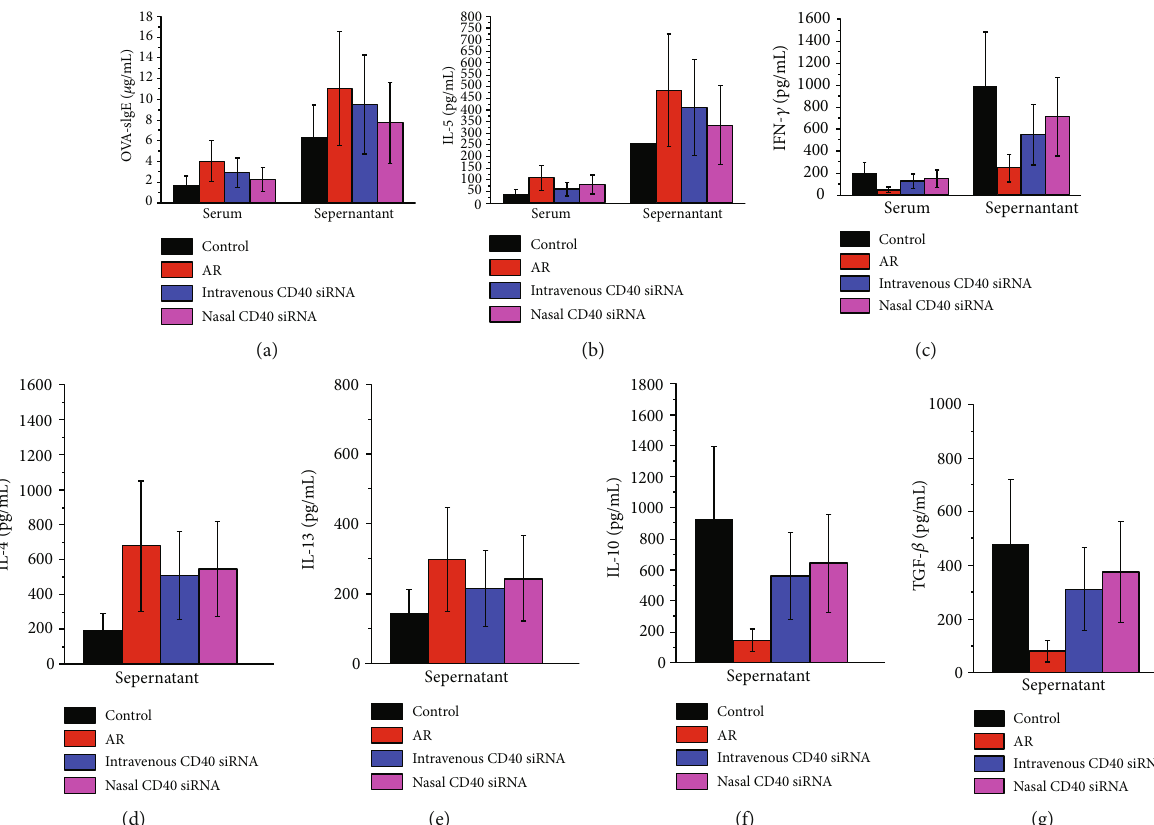
Figure 2: (a) Serum and supernatant levels of OVA-sIgE were measured by ELISA. AR mice produced signi fi cantly more OVA-sIgE than